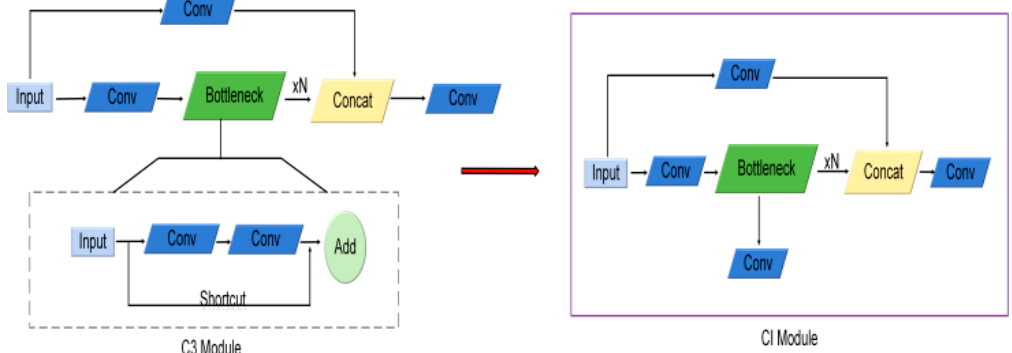
Figure 5. Replace C3 module with CI module.